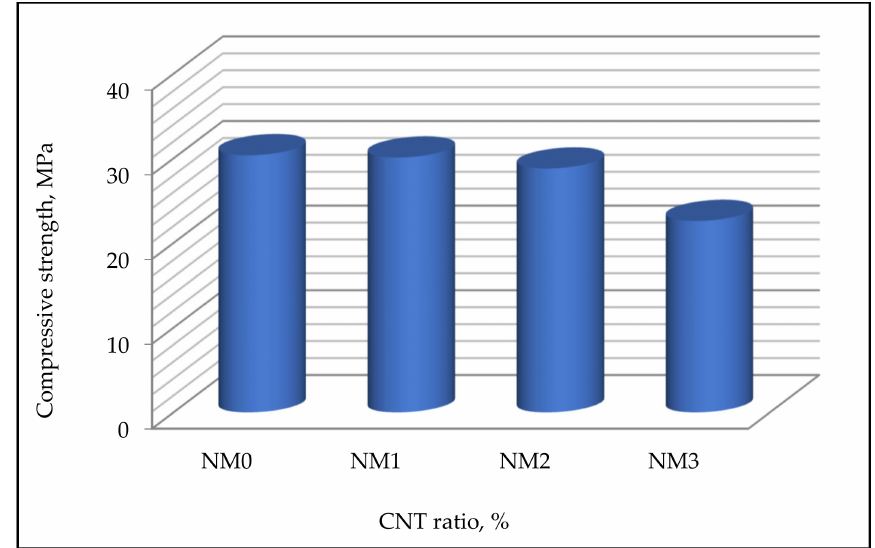
Figure 7. Compressive strength.